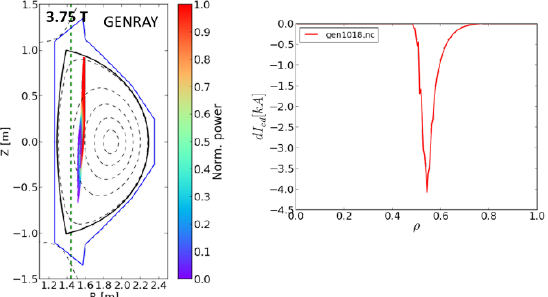
Fig. 3. The ray trajectory and driven current profile for 105 GHz O1 wave obtained from GENRAY code with toray module and 48 Gaussian zone.